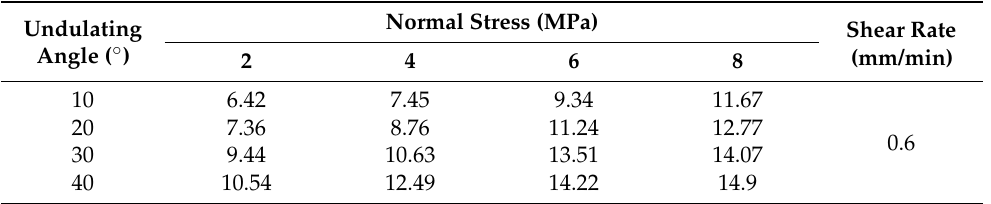
Table 2. Shear strength of structural planes with different undulating angles under different normal stresses at a 0.6 mm/min shear rate